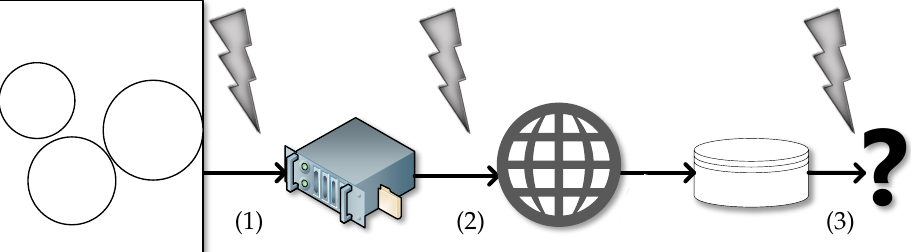
Figure 1. Process steps when doing industrial data science with the machine on the left and the typical way data may flow from some kind of edge device over the internet or cloud to a database. In addition, potential positions for pitfalls are shown: (1): Data acquisition from the machine, (2): Transferring data to the internet/ research institute, (3) understanding and labeling the